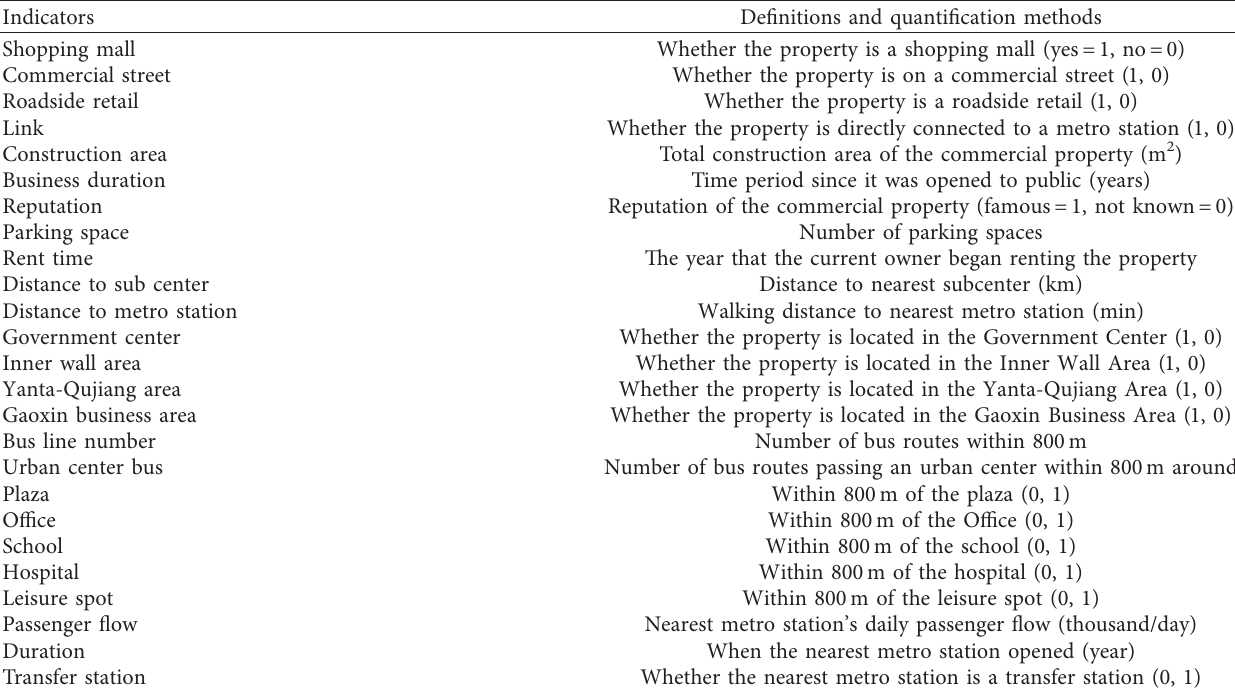
Table 3: Initial indicator set: definitions and quantification